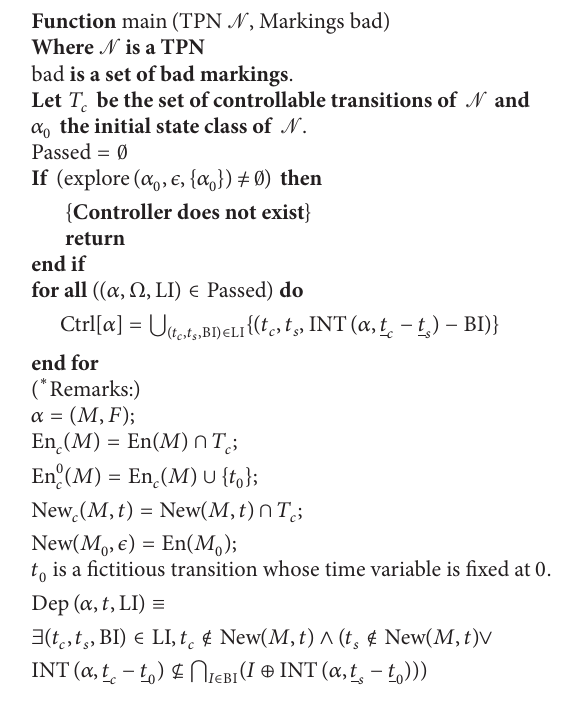
Algorithm 1: On-the-fly algorithm for the safety control of TPN-Part I.